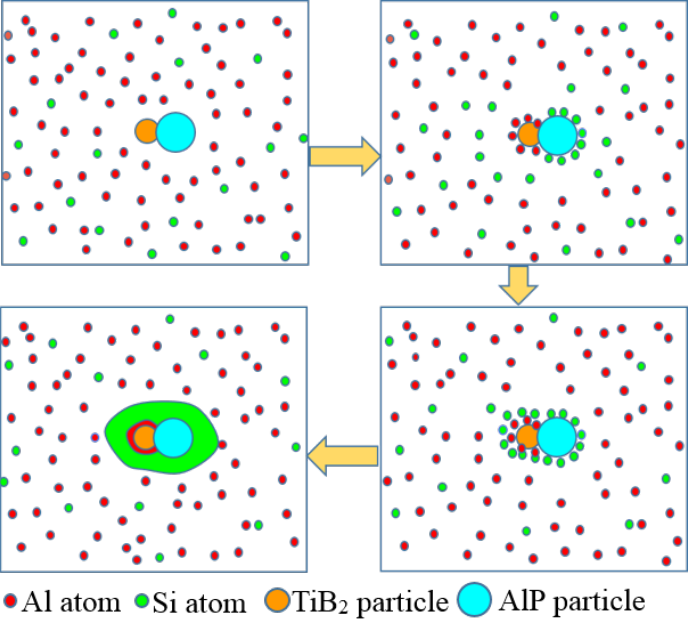
Figure 9. Schematic description of the duplex nucleation mechanism of AlP and TiB 2 in the near- eutectic Al-Si eutectic Al-Si alloy.